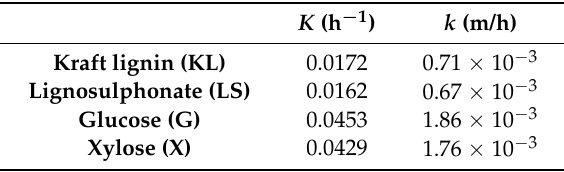
Table 4. Values of effective mass transfer constants K , and permeabilities k of the SILMs based on [BMIM][DBP] supported in PTFE